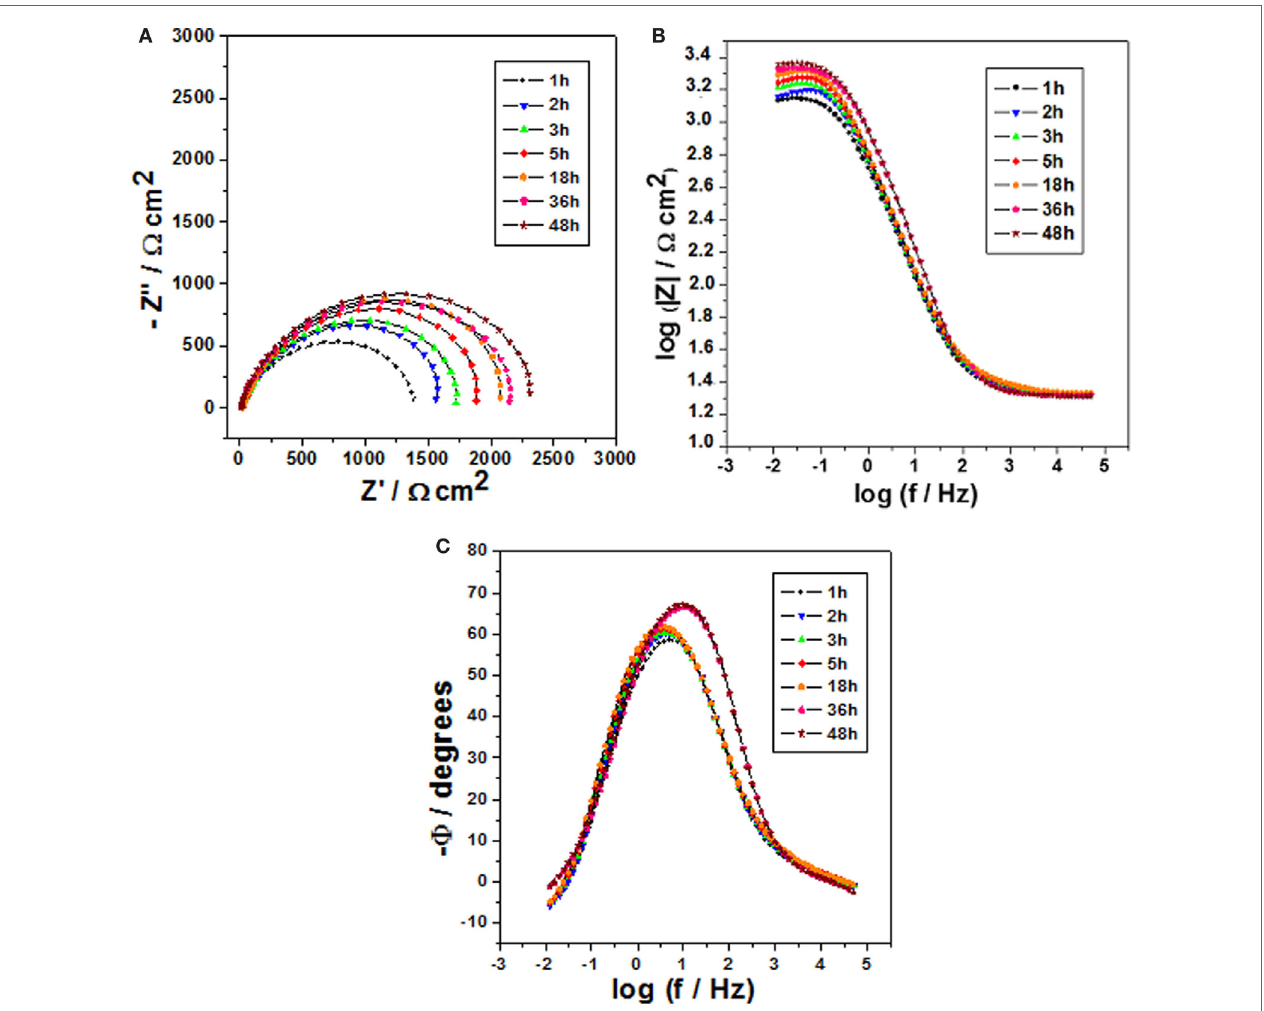
FigUre 5 | impedance diagrams: nyquist (a) and Bode (B,c) plots for carbon steel after different immersion times in 0.1 mol/l nacl at ph 9 and containing 1 wt.% of halloysite nanotubes with encapsulated dodecylamine